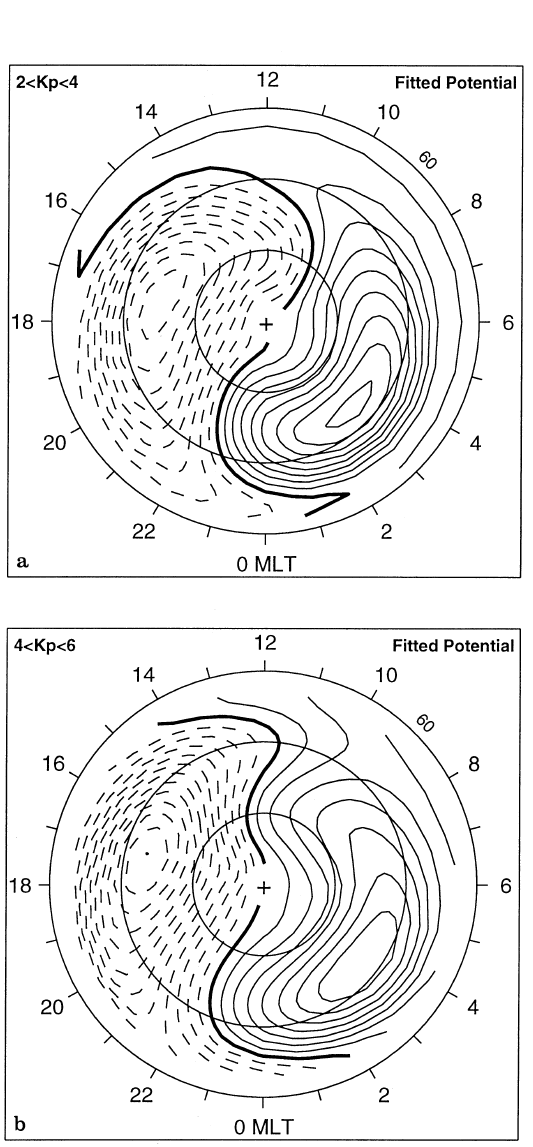
Fig. 4a,b. Analytical models for the convection potential represented in polar maps identical to Fig. 3 (see text for